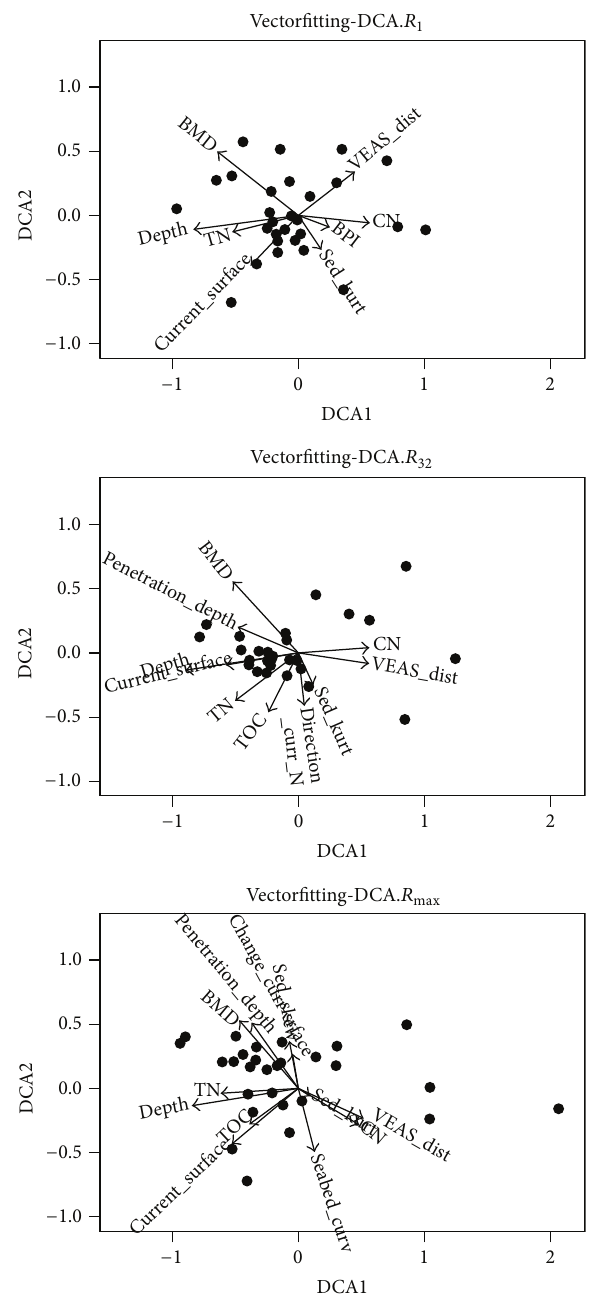
Figure 4: DCA diagrams for axes 1 and 2 with vector fitted environmental variables related to the three selected abundance ranges ( 𝑅 1 , 𝑅 32 , and 𝑅 max ). Variables were fitted to the DCA axes by application of the envfit function with selection criteria |𝜏| ≥ 0.225. The length of the vectors indicates their degree of correlation. Sites are shown as black dots. Environmental variables are described in Table 2. DCA axes are scaled in SD units of compositional